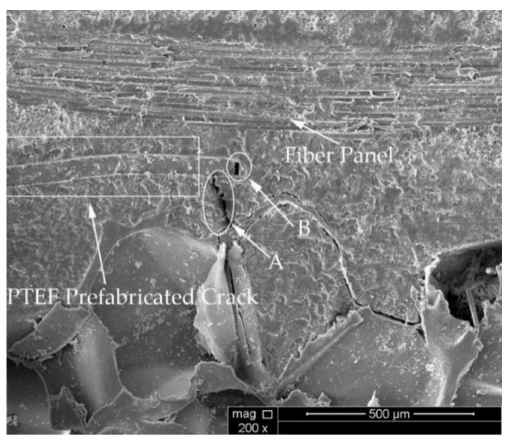
Figure 12. SEM images of FH-0 (A is the foam pore, and B is the crack initiation point).